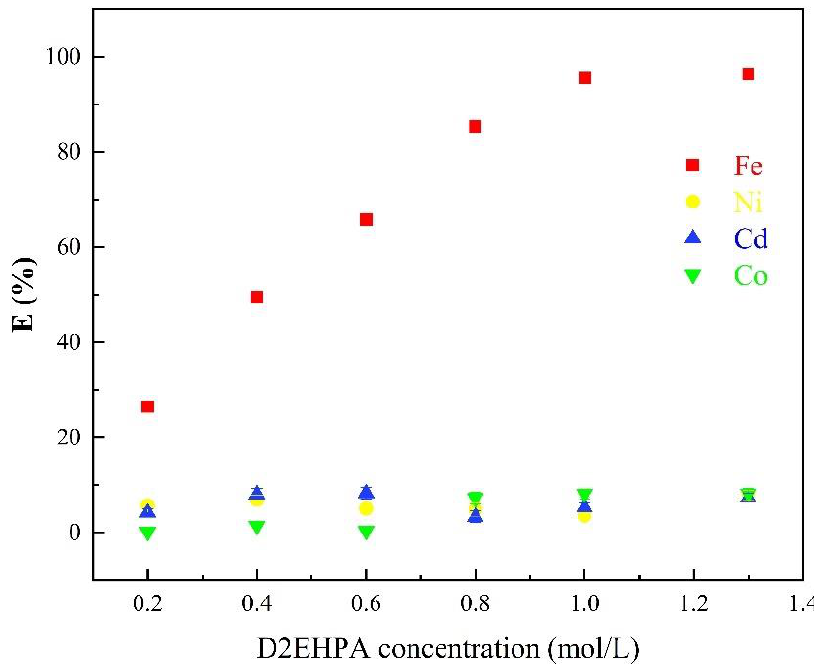
Figure 6. Effects of D2EHPA concentration under the conditions: room temperature (298 K), initial [Fe 3+ ] = 12.25 g/L, extraction time = 20 min, saponification rate = 70%, initial pH = 1.00, and phase ratio = 1:1.